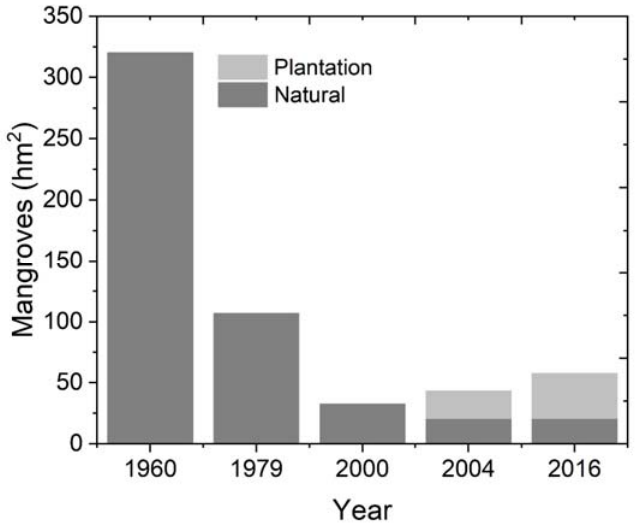
Figure 12. Historical changes in mangrove area in coastal Xiamen from 1960 to 2016, including both natural and plantation mangroves .